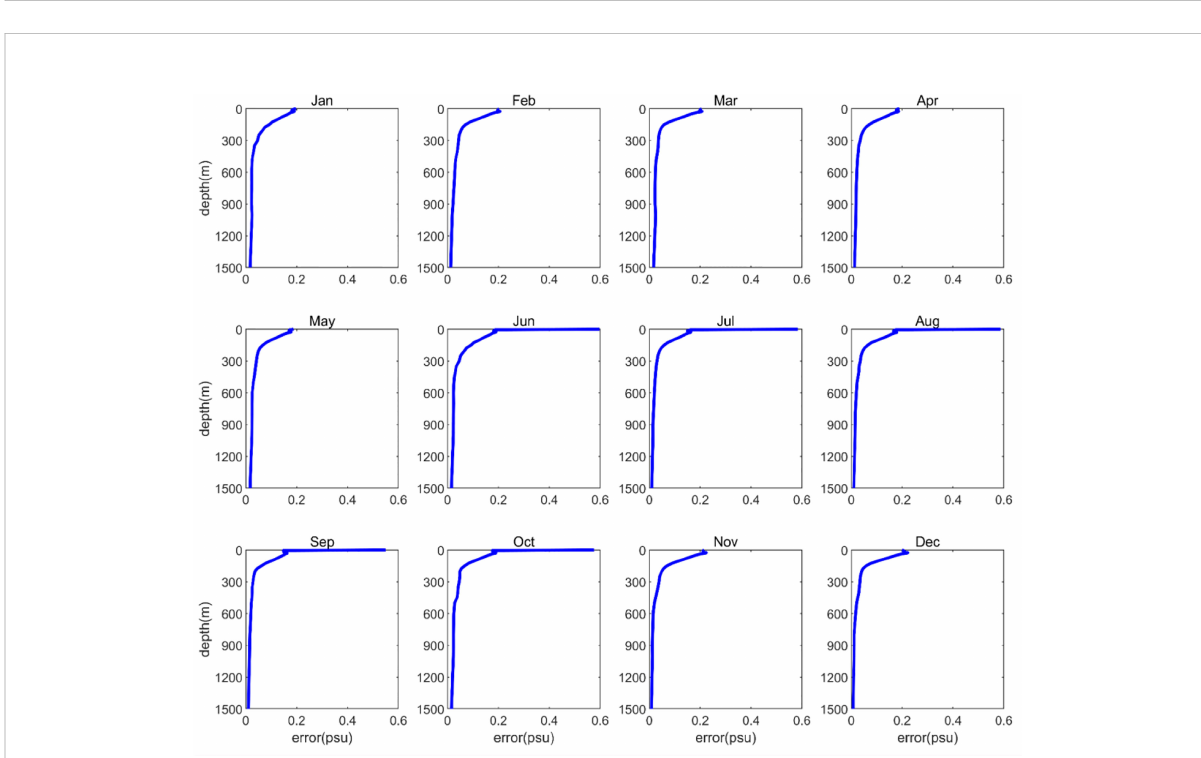
FIGURE 11 Vertical distribution of expanded salinity fi eld monthly errors in the northern South China Sea (cross-validation